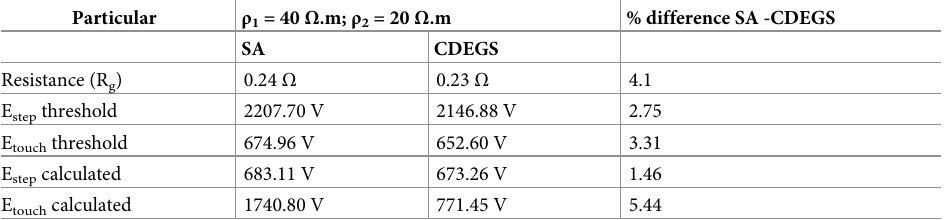
Table 9. Results for grounding system in horizontal two-layer soil ( ρ 1 > ρ 2 ).